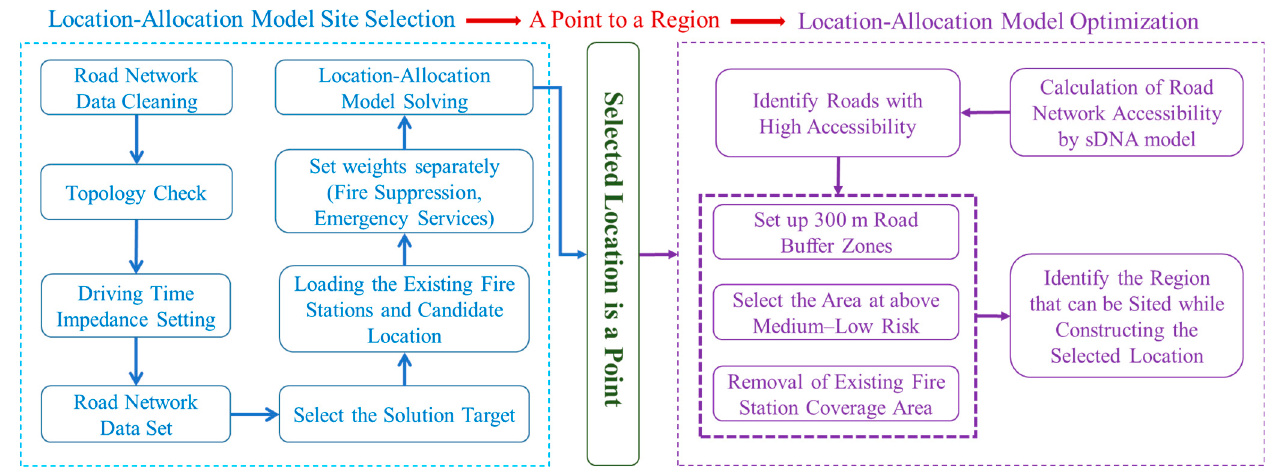
Figure 2. Framework used for the spatial extension of a selected point for locating a fire station.